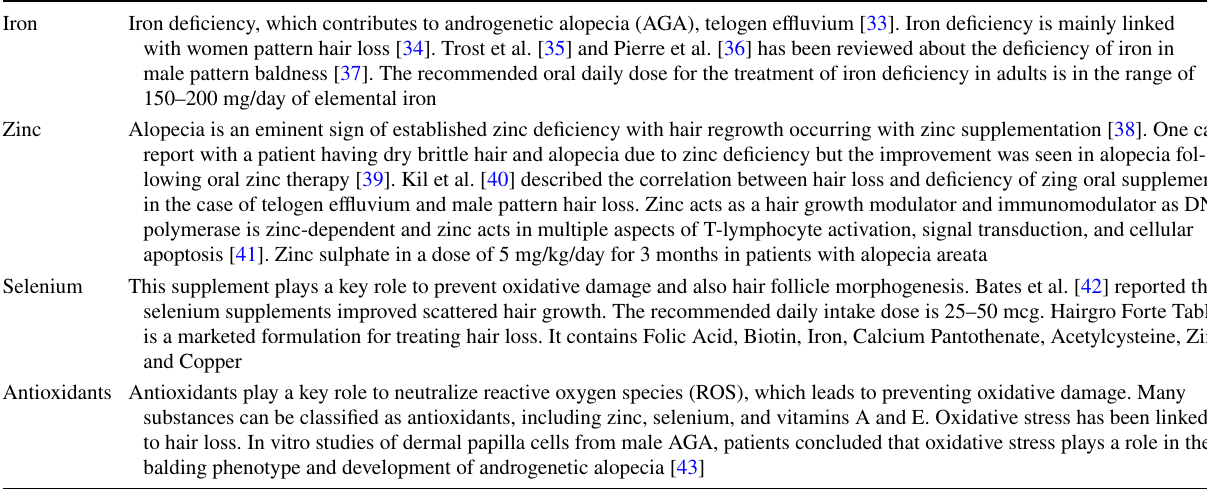
Table 3 Trace elements for androgenic alopecia